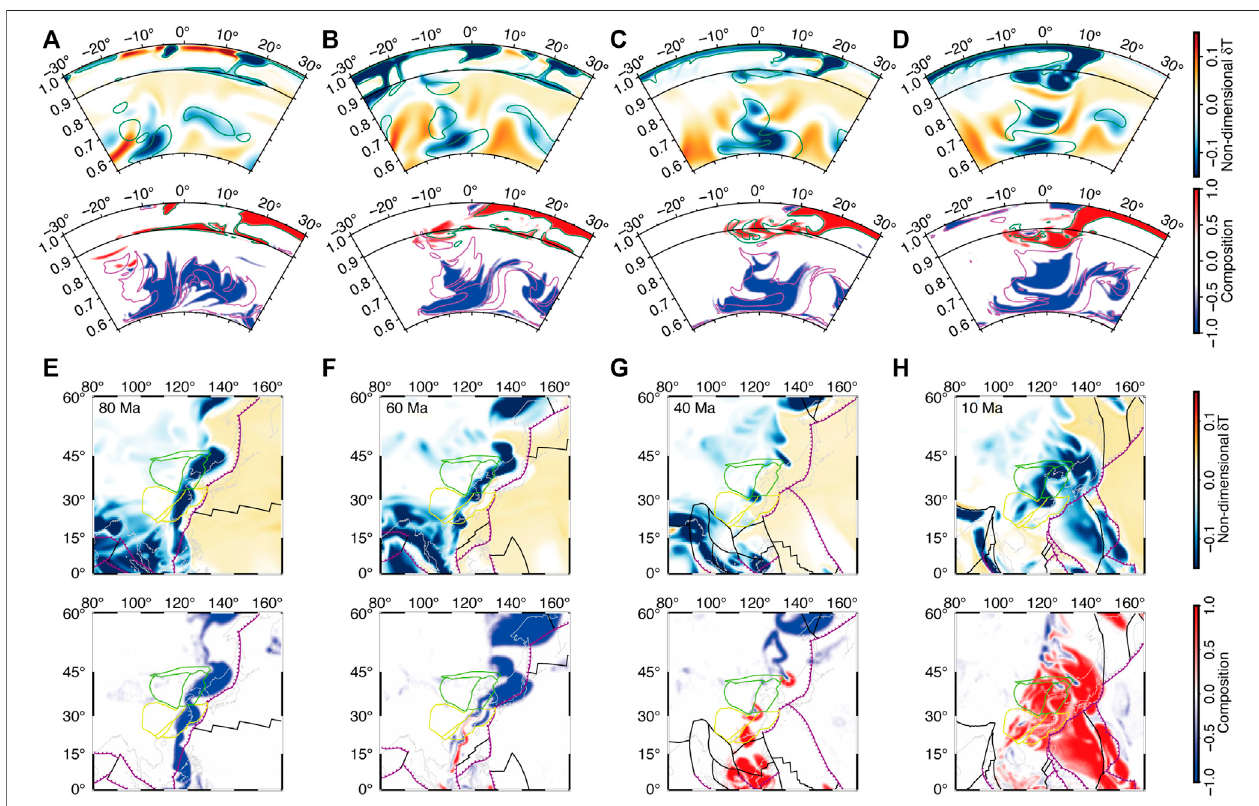
FIGURE6| SlabstructuresoftheIzanagi-Paci fi cPlatebeneath theEasternAisaforcase3inwhichtheplatemotionhistory after90 MaisfromYang(2013). (A – D) are present-day temperature and composition of slab structures for cross-sections P1-P4 in Figure 1 , respectively. (E – H) are some time snapshots of the residual temperature and composition fi elds at 670 km depth, respectively. Line descriptions are the same as that in Figure 5 .